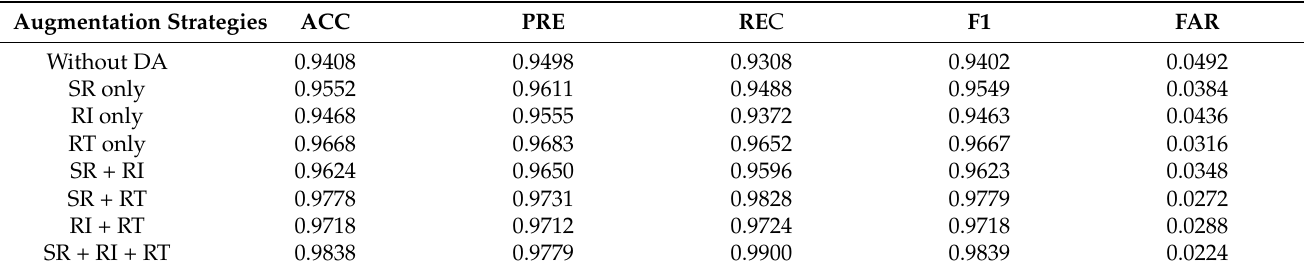
Table 8. Comparisons of different data augmentation(DA)